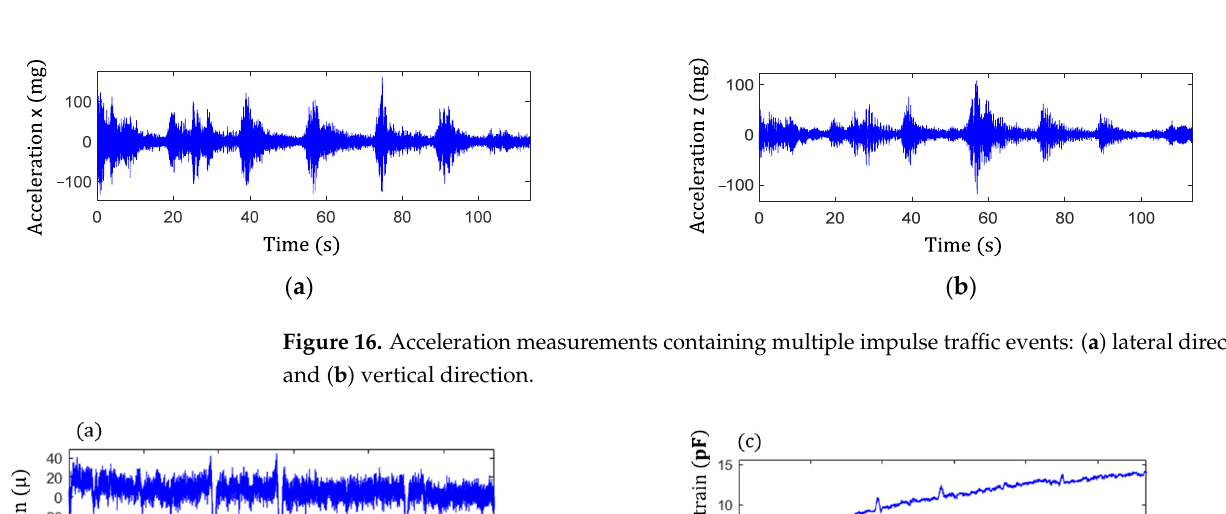
Figure 15. Single impulse traffic event: ( a ) raw data and ( b ) magnitude, |𝑊(𝑡, 𝑠)| (cid:3007) , of cross-frame strain, 𝐹(𝑡) , and ( c ) raw data and ( d ) magnitude, |𝑊(𝑡, 𝑠)| (cid:3004) , of large-area strain, ∆𝐶(𝑡) .